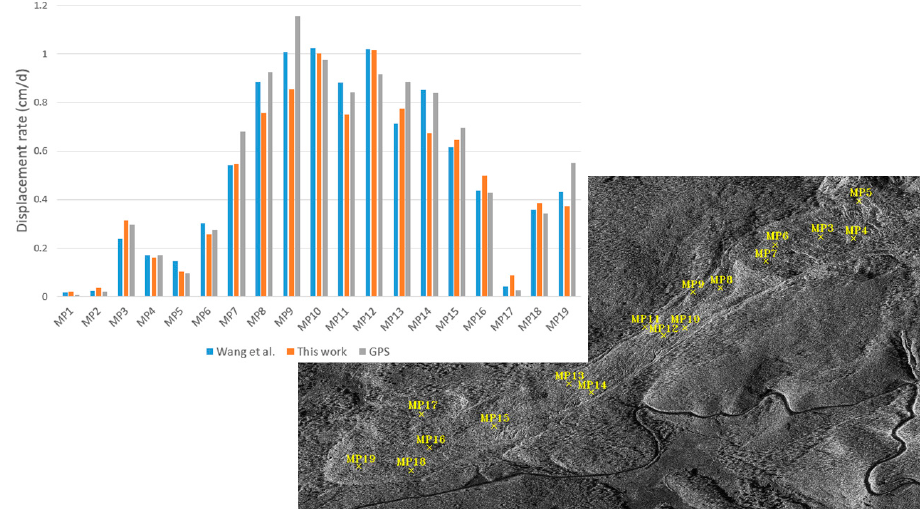
Figure 5. Comparison between space-borne COSMO-SkyMed displacement rates (orange), airborne UAVSAR displacement rates (blue) and GPS displacement rates (gray) for the 19 USGS measurement points. UAVSAR and GPS displacement rates have been extracted from [26].